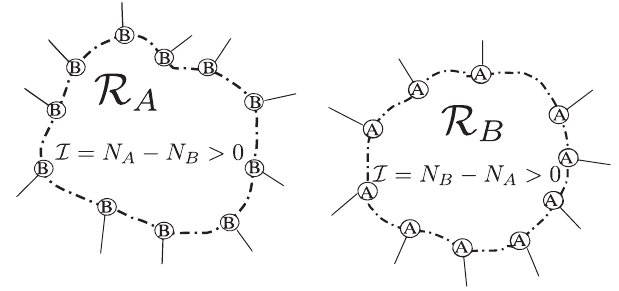
FIG. 1. Topologically protected zero modes of bipartite random hopping problems are expected to live in R -type regions of the lattice, with local sublattice imbalance and a site boundary consisting entirely of sites belonging to the sublattice that is locally in the minority [20]. See Secs. I – III for a detailed